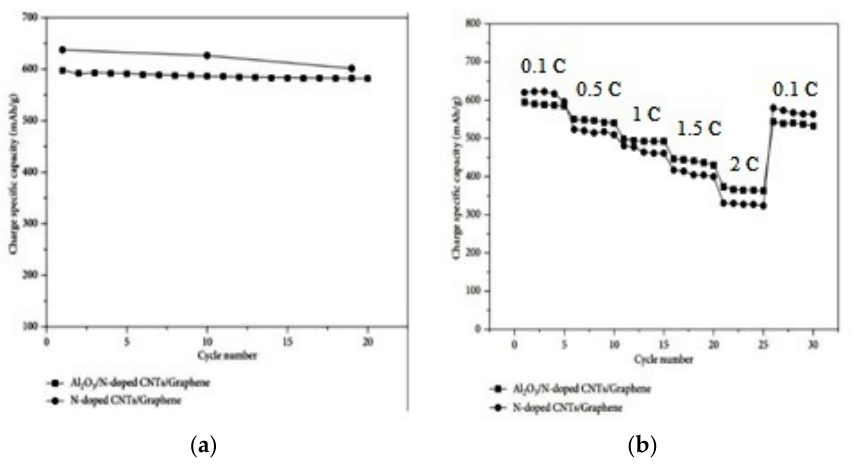
Figure 3. ( a ) The N-doped carbon nanotubes/graphene composite Al 2 O 3 /N-doped carbon nanotubes/graphene at different cycles on the charge specific capacity of 0.1 C. ( b ) Rate capability (between 0.01 V and 3 V) with different cycles for the N-doped CNTs/graphene composite and Al 2 O 3 /N-doped CNTs/graphene [35].